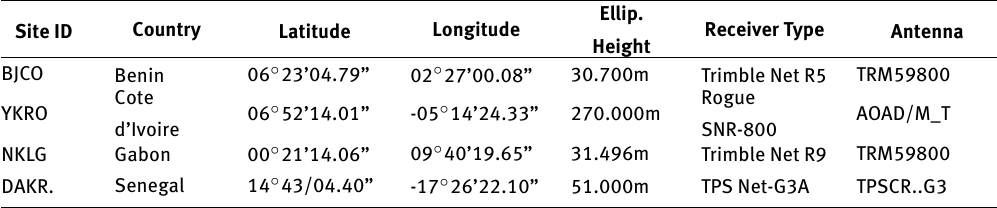
Table 1: IGS Stations used